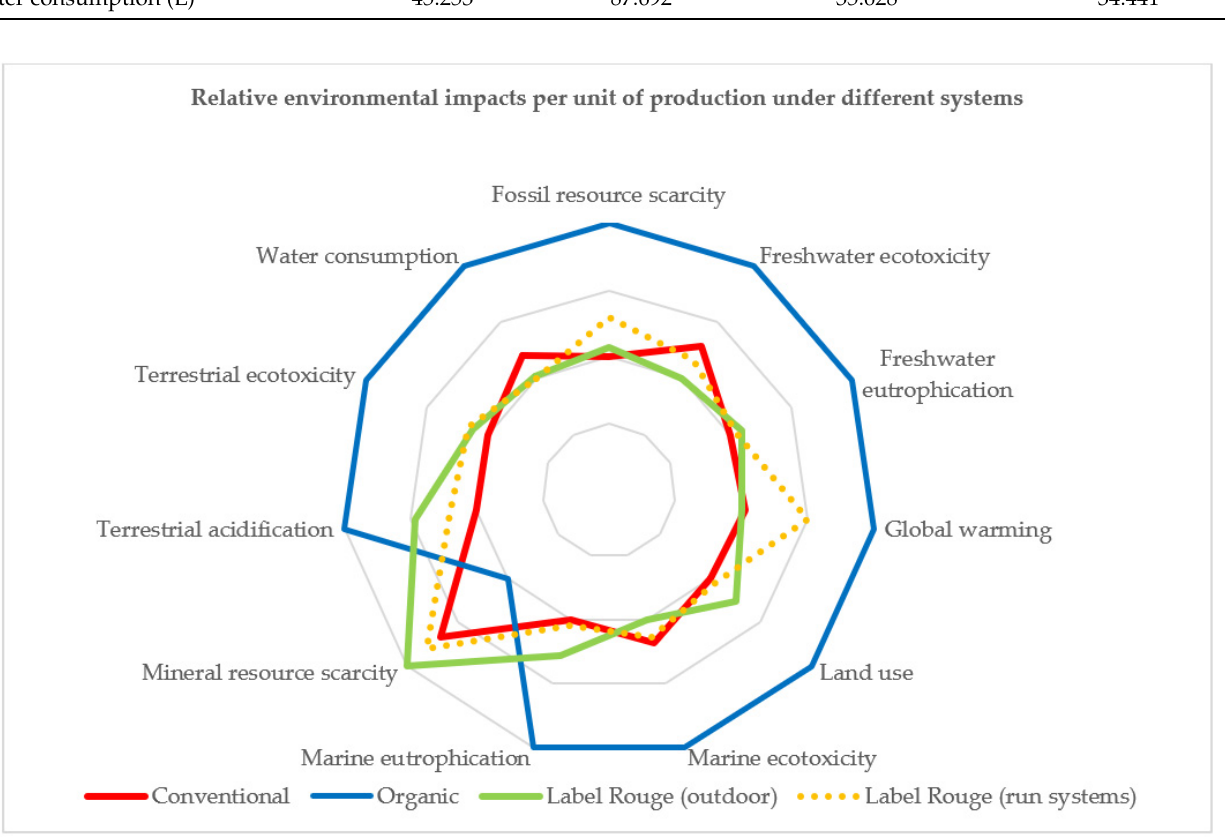
Figure 2. Pig meat environmental impact per unit production (kg) across organic, Label Rouge and Conventional systems relative performance and hotspot map identification map: Data obtained from AGRIBALYSE ® database and computed using OpenLCA 1.10.2 [35,36]. Table 2. Pig meat environmental impact per unit production (kg) across organic, Label Rouge and Conventional systems: Data obtained from AGRIBALYSE ® database and computed using OpenLCA 1.10.2 [35,36].